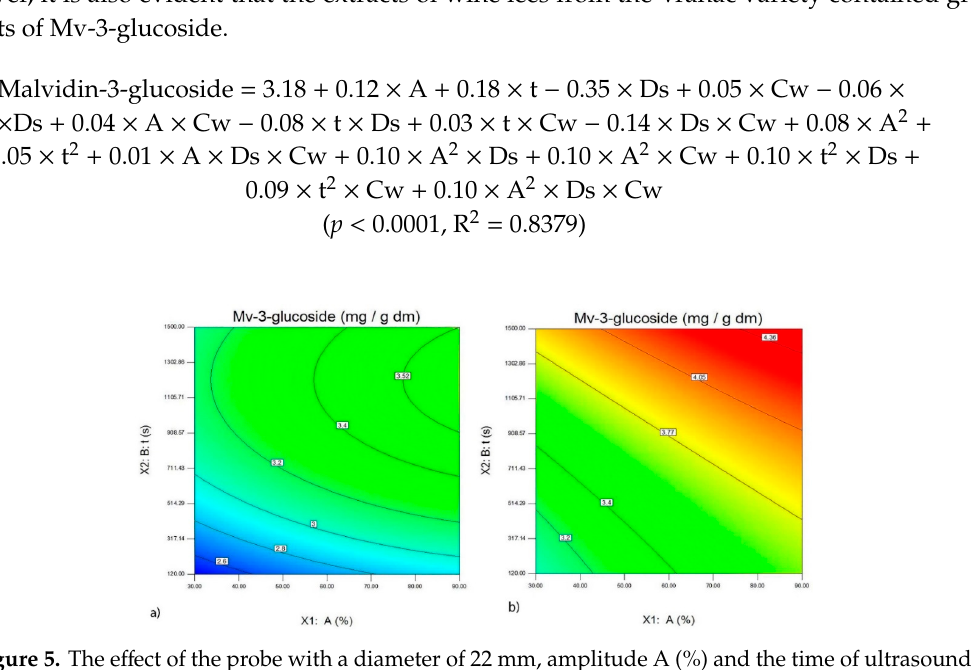
Figure 4. The effect of the probe with a diameter of 22 mm, amplitude A (%) and the time of ultrasound extraction t (s) on the quantity of Kaempferol (mg/g d.m.) in the extracts of the wine lees of the Merlot variety ( a ) and the wine lees of the Vranac variety ( b ).